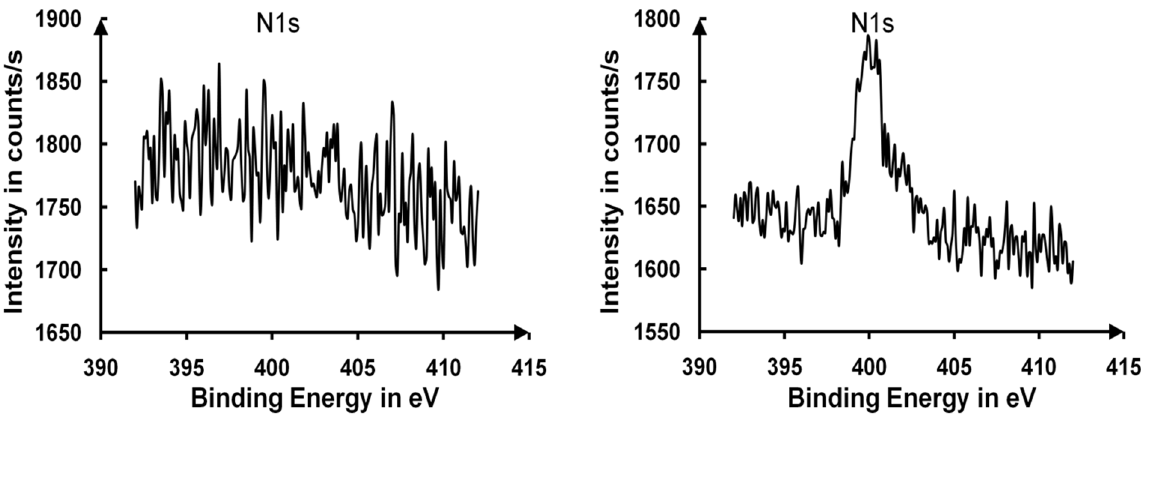
Figure 15. XPS signals of an uncured sample ( a ) and a cured sample exposed for 24 h to ammonia vapor ( b ). vapor ( b